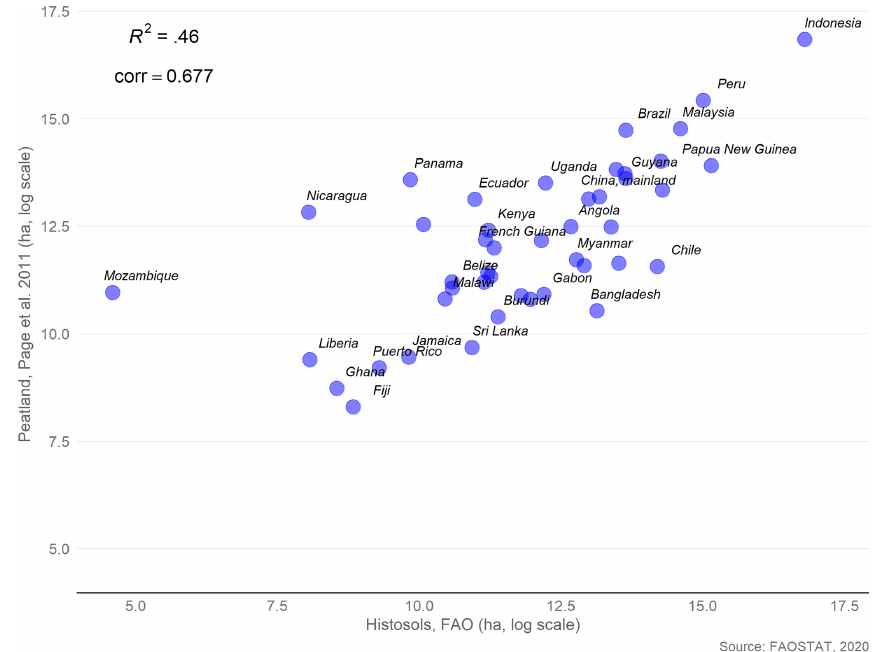
Figure 8. Scatterplot of log-transformed area estimates for organic soils (Page et al., 2011) and FAOSTAT.